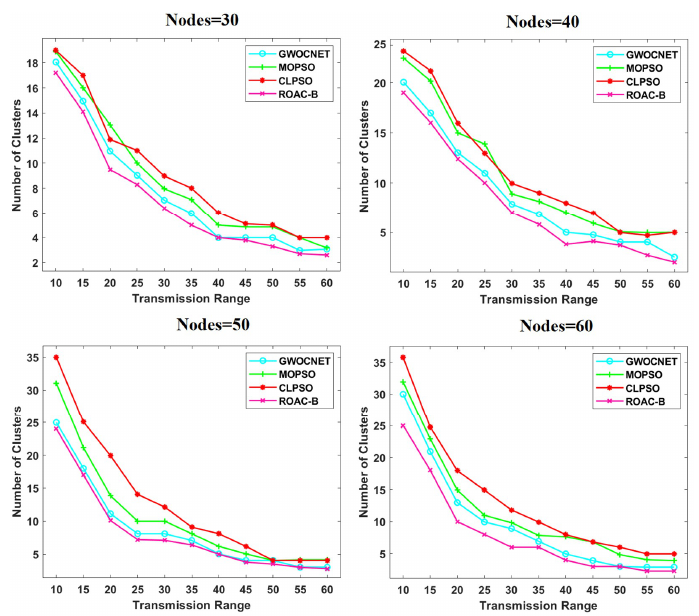
Figure 5. Number of clusters vs. transmission range in a 100 m × 100 m grid (Node count 30–60).